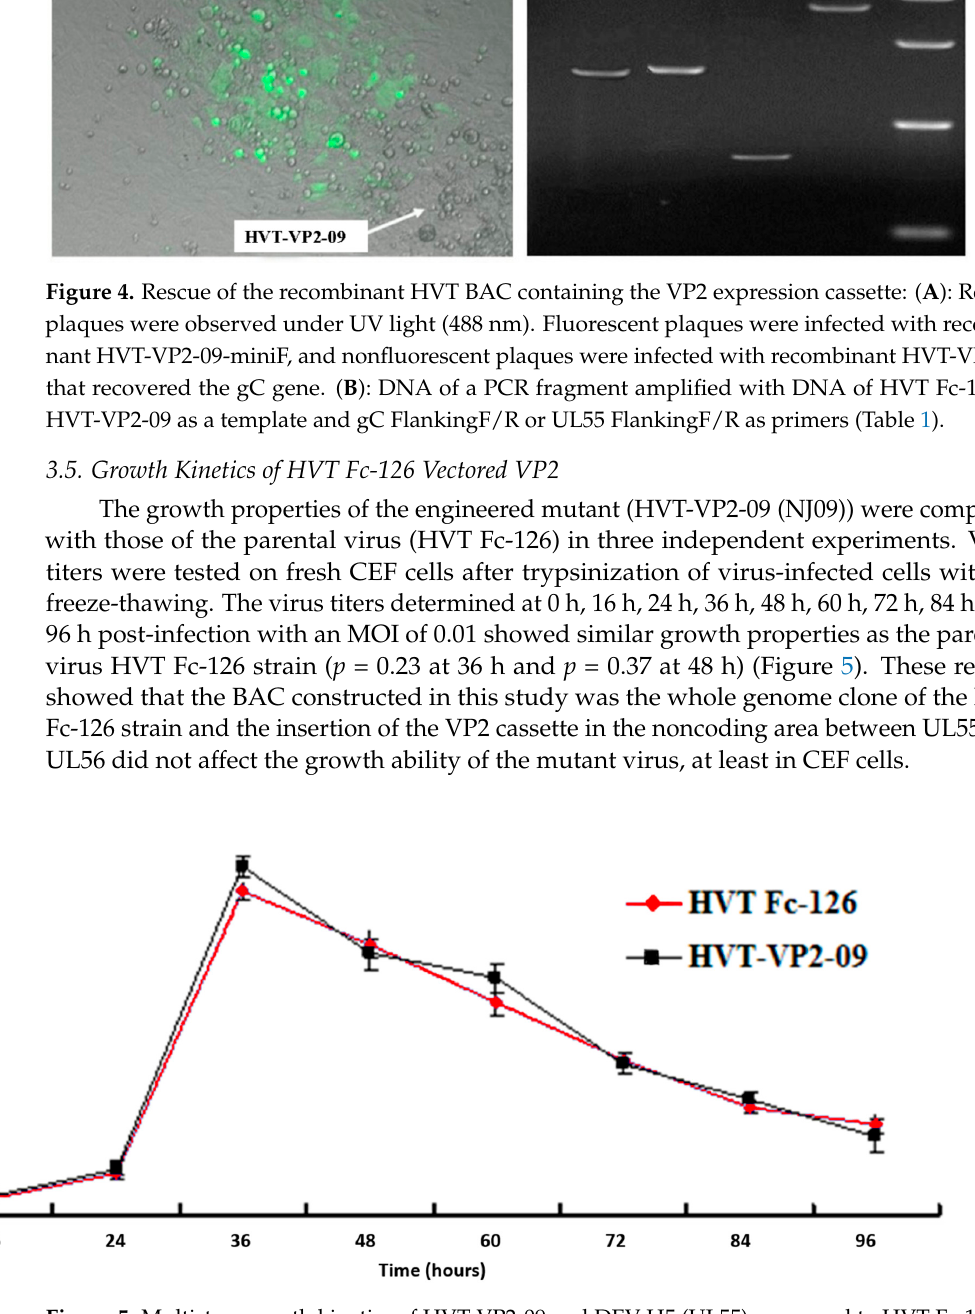
Figure 5. Multistep growth kinetics of HVT-VP2-09 and DEV-H5 (UL55) compared to HVT Fc-126 on CEFs. Titers of cell-associated viruses. Titers were determined by plaque forming units of 0.1 mL of samples in three independent tests. Average titers were determined at the indicated time points after infection with an MOI of 0.01. Error bars represent the standard deviations. The recombinant HVT-VP2 virus titers showed similar growth properties as the parental virus HVT Fc-126 strain ( p = 0.07 at 72 h and p = 0.08 at 84